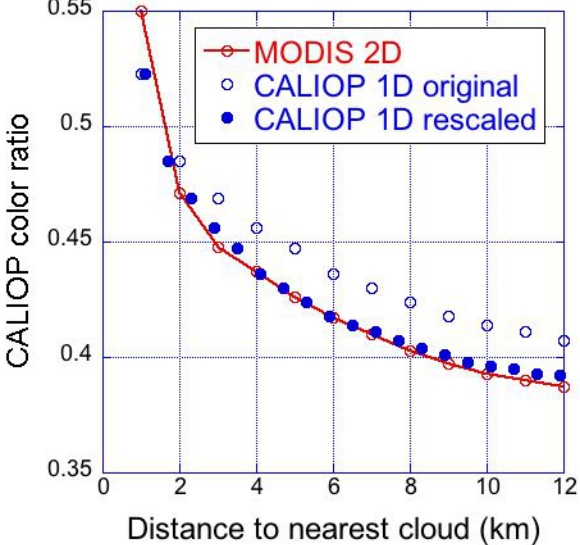
Fig. 5. Median CALIOP color ratio (integrated up to 3km altitude) near clouds detected by the 2-D MODIS cloud mask (red circles), by the 1-D CALIOP cloud mask (blue empty circles) and if the dis- tance to clouds detected by the 1-D CALIOP mask are rescaled to estimate the effect of clouds outside the lidar track (blue full cir- cles). The plot extends to 12km, the 2-D distance that corresponds to a 1-D distance of 20km for the blue line in Fig. 4a. The plot is based on the yearlong global dataset, with the number of used lidar profiles decreasing from over 4 million near clouds to just un- der 300000 12km away from clouds. Vertically integrated color ratio is calculated as the ratio of vertically integrated backscatters at 532nm and 1064nm. Fig. 6. (a) Annual median distance to low clouds; (b) cloud frac-